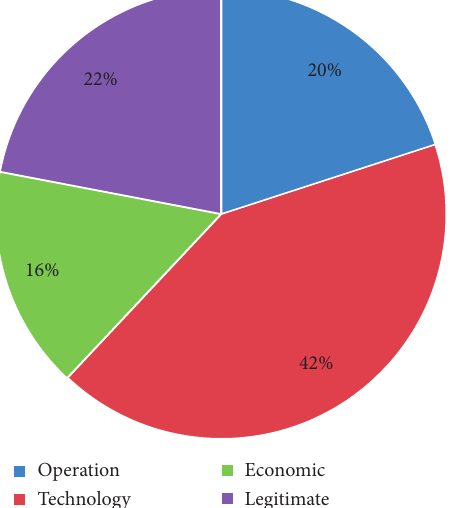
Figure 8: Portion of each category.